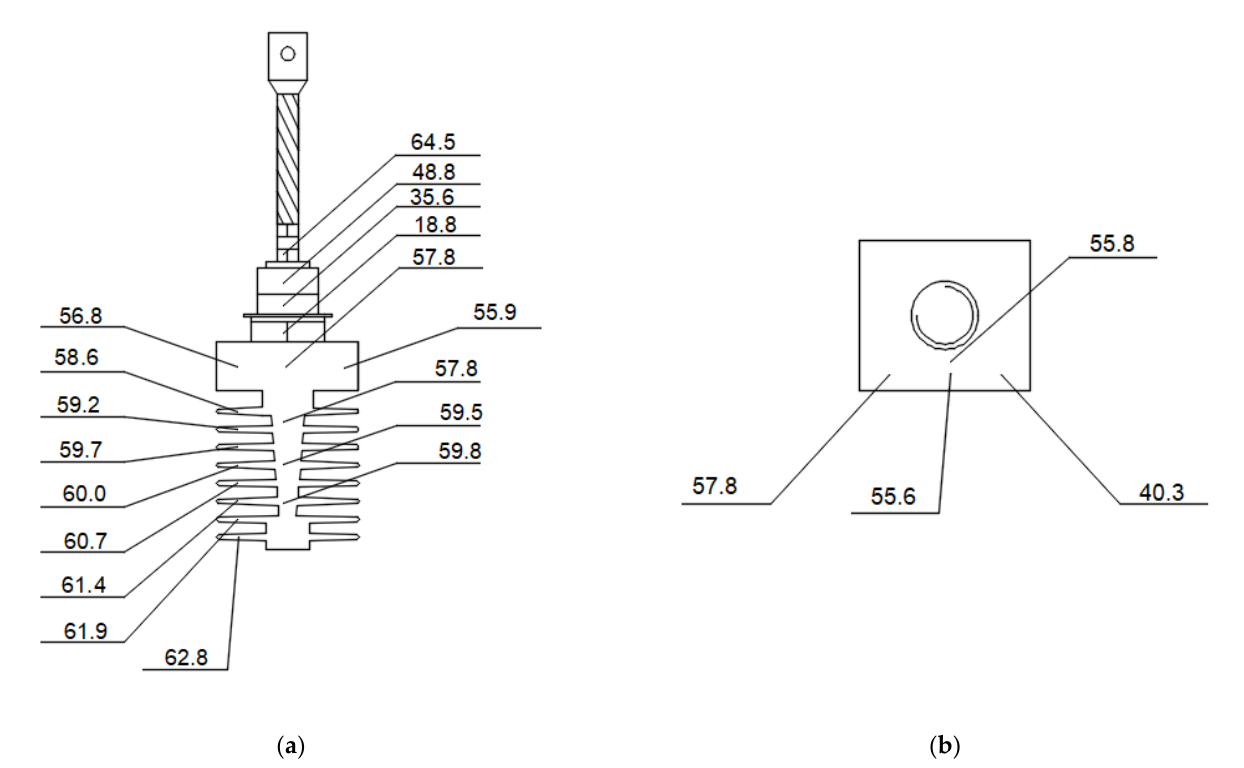
Figure 21. Differences ( T j − T s ) between the junction temperature ( T j ) and the surface temperatures ( T S ) (from Tables 6 and 7) at points presented in Figure 2 for a power of P j = 117.99 W: ( a ) side view; ( b ) top